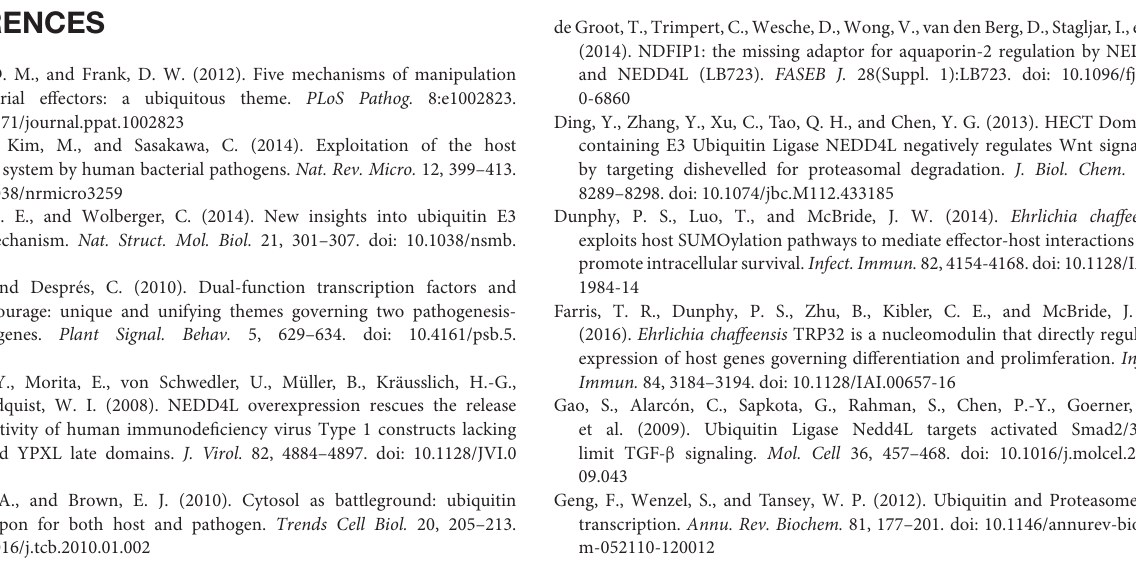
Figure S1 | Expression levels of TRP32 wild type and lysine mutant expression constructs in HeLa